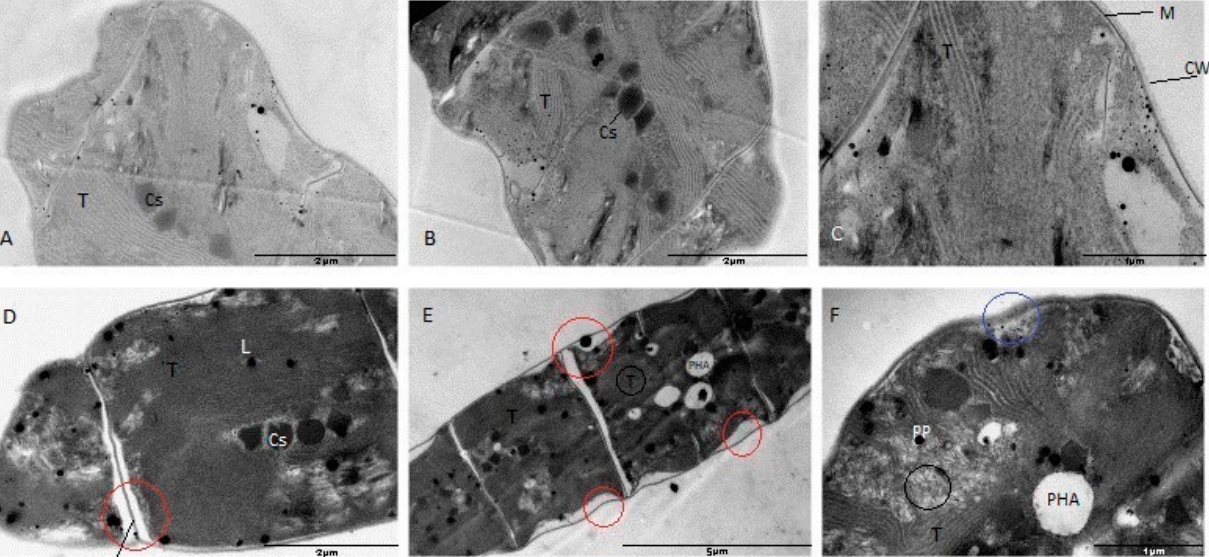
Figure 9. The ultrastructure of A. platensis cells ( A – C )—control, ( D – F )—cells grown in the medium containing sodium selenite in concentration of 200 mg/L. Cs—carboxisomes; T—thylacoids; M— membrane; CW—cell wall; L—lipid inclusions; PHA—polyhydroxyalkanoates; PP—polyphosphate bodies ; S—septum; black circles—disintegration and disorganization of thylakoids, red circles—space between cell membrane and cell wall/intercellular septum, blue circle—modification of the cell wall/exopolysaccharides density. Scale bar in ( A ) 2 µm, ( B ) 2 µm, ( C ) 1 µm, ( D ) 2 µm, ( E ) 5 µm, ( F ) 1 µm.